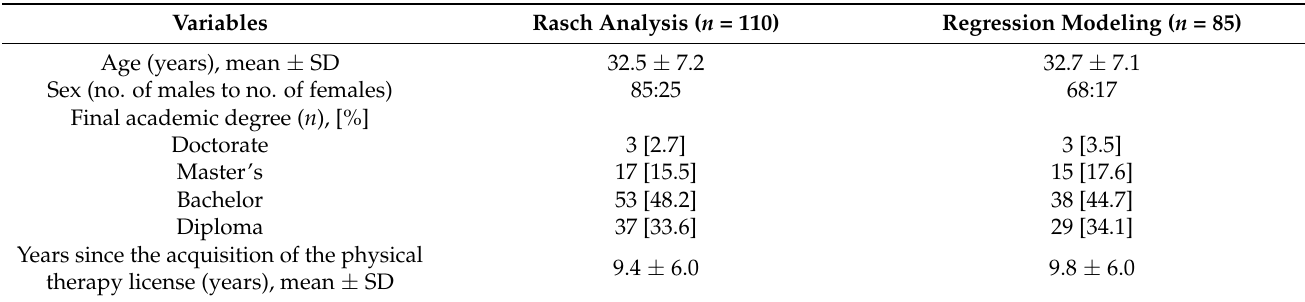
Table 1. Demographics of the participants.